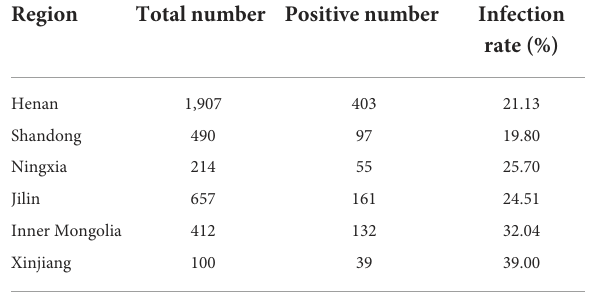
TABLE 1 Infection rates of CEV/OEV in different regions in